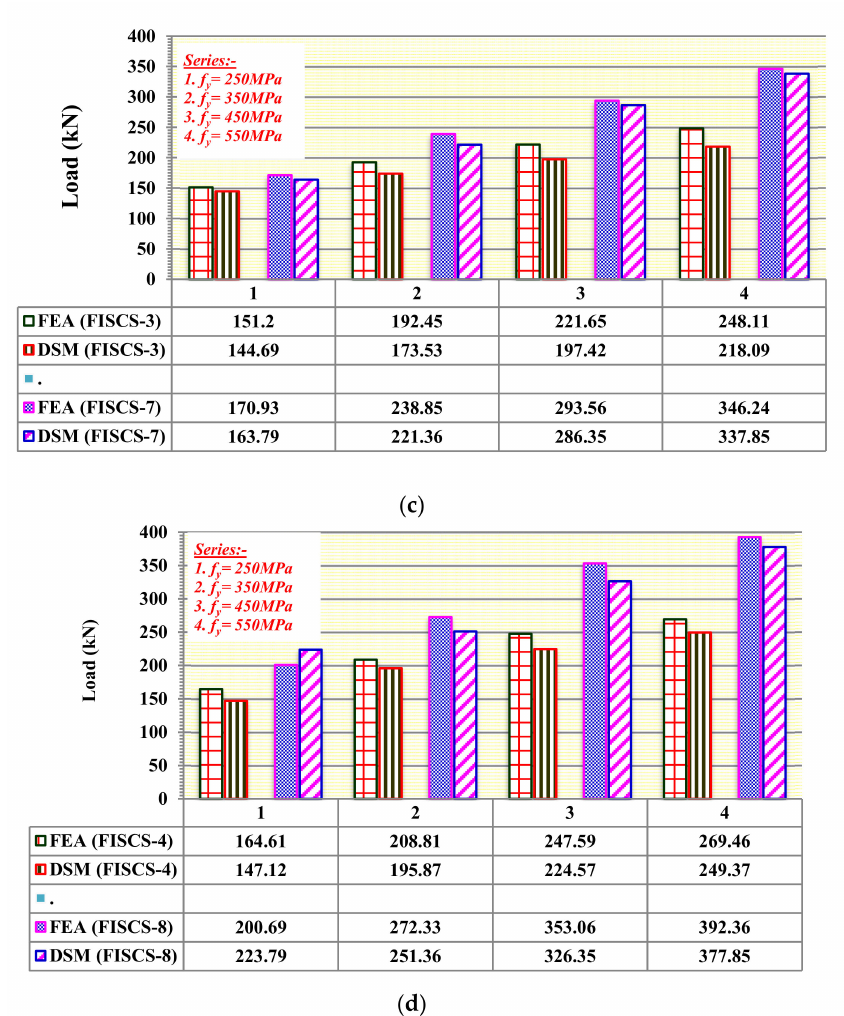
Figure 22. Column strengths from the FEA and current DSM for face-to-face intermediate stiffened channel sections-L2000 mm. ( a ) FISCS 1 & 5 (L2000 mm). ( b ) FISCS 2 & 6 (L2000 mm). ( c ) FISCS 3 & 7 (L2000 mm). ( d ) FISCS 4 & 8 (L2000